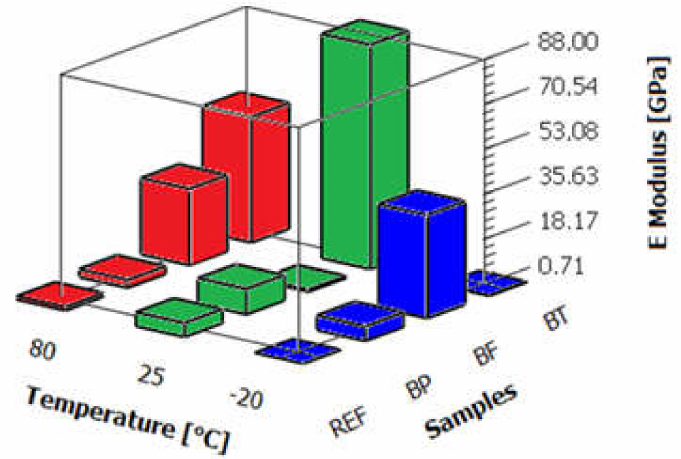
Figure 9. Young’s E modulus versus temperature for sample VE (REF) and composites VE reinforced with basalt powder (BP), basalt fibre (BF) and basalt textile (BT) (Table